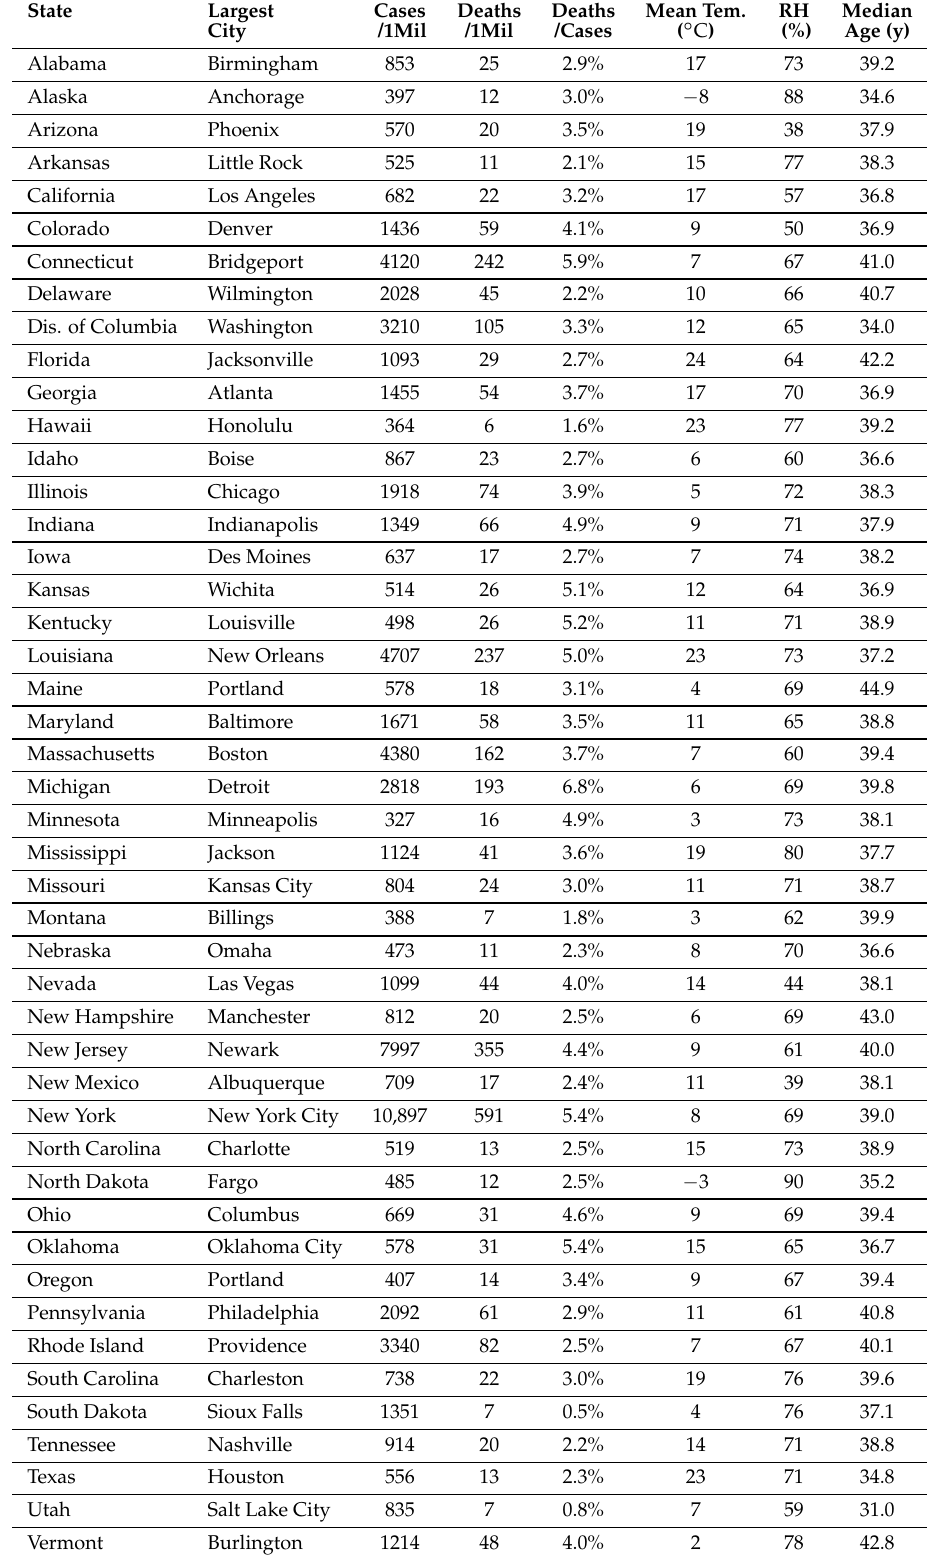
Table 4. Number of deaths per million people, and weather temperature and relative humidity means for March 2020 for each state of the USA. Median population age is added for comparison. The Pearson correlation coefficients in the parentheses exclude the State of Louisiana. See text for